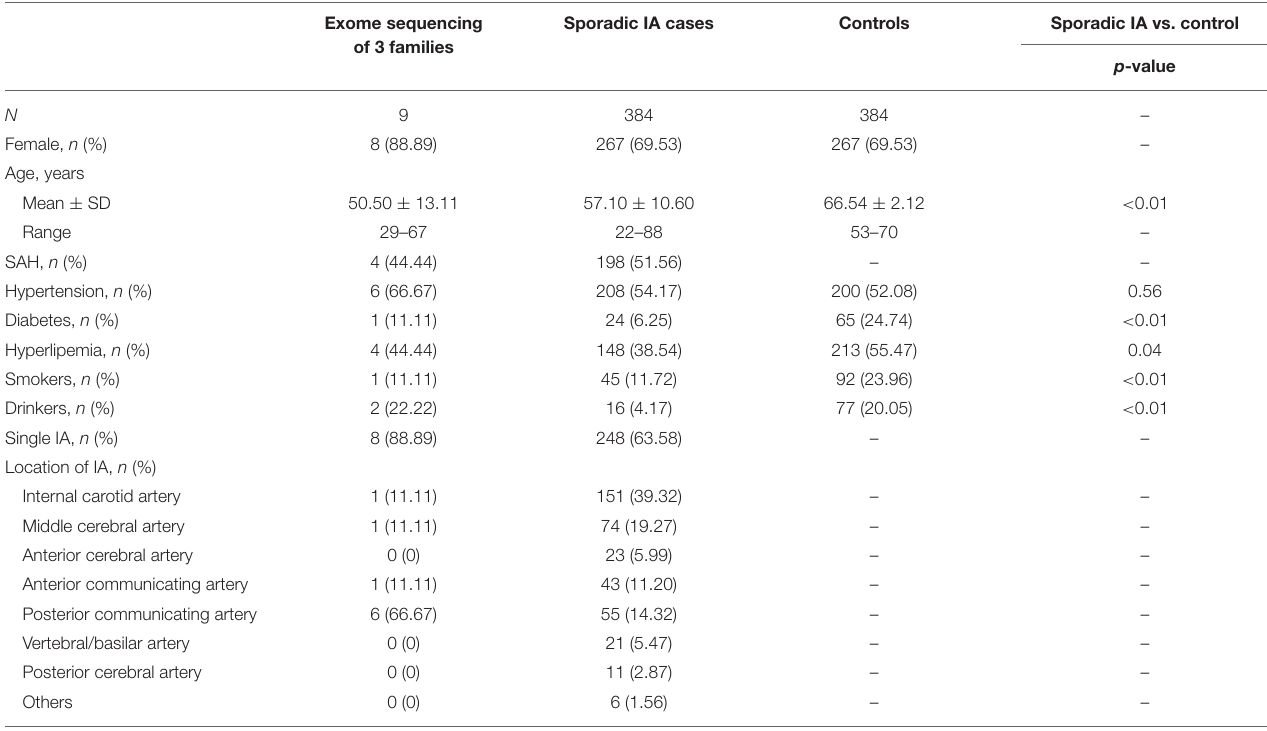
TABLE 1 | Clinical and demographic characteristics of study